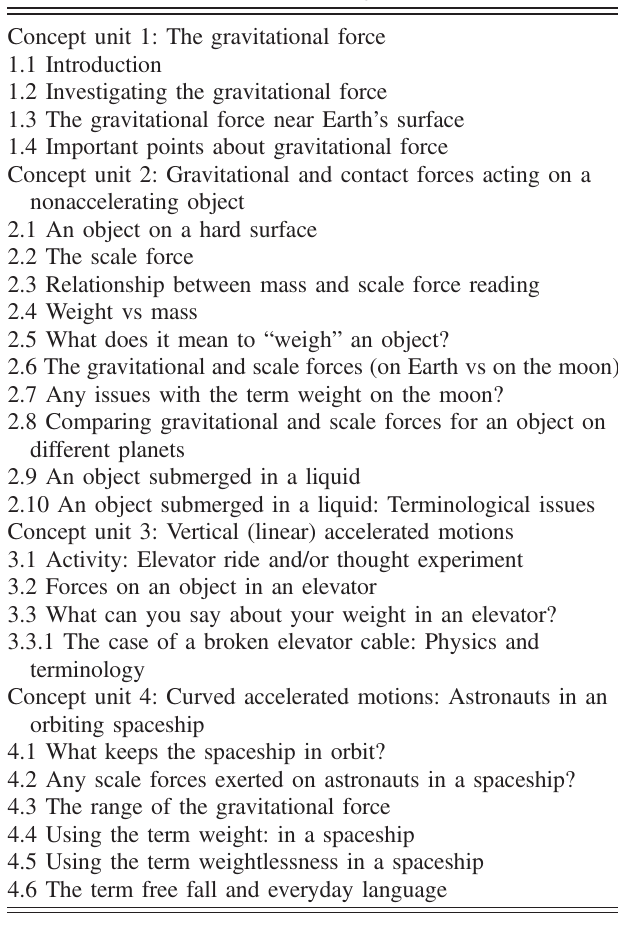
TABLE I. Module structure and